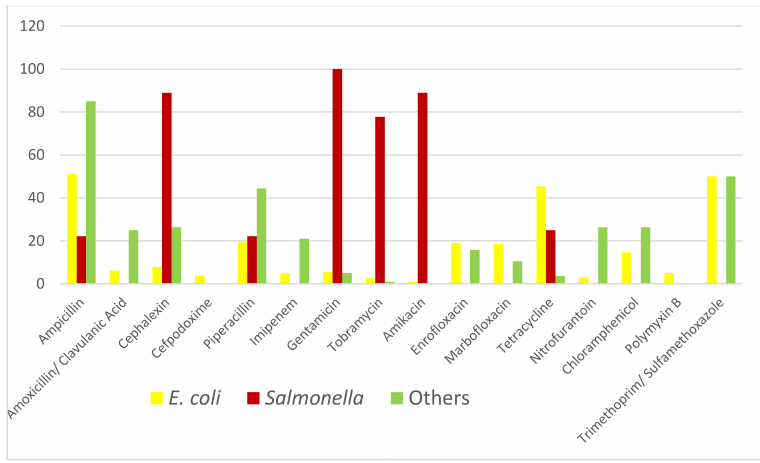
Figure 5. Di ff erences in percentages of resistant between bacteria